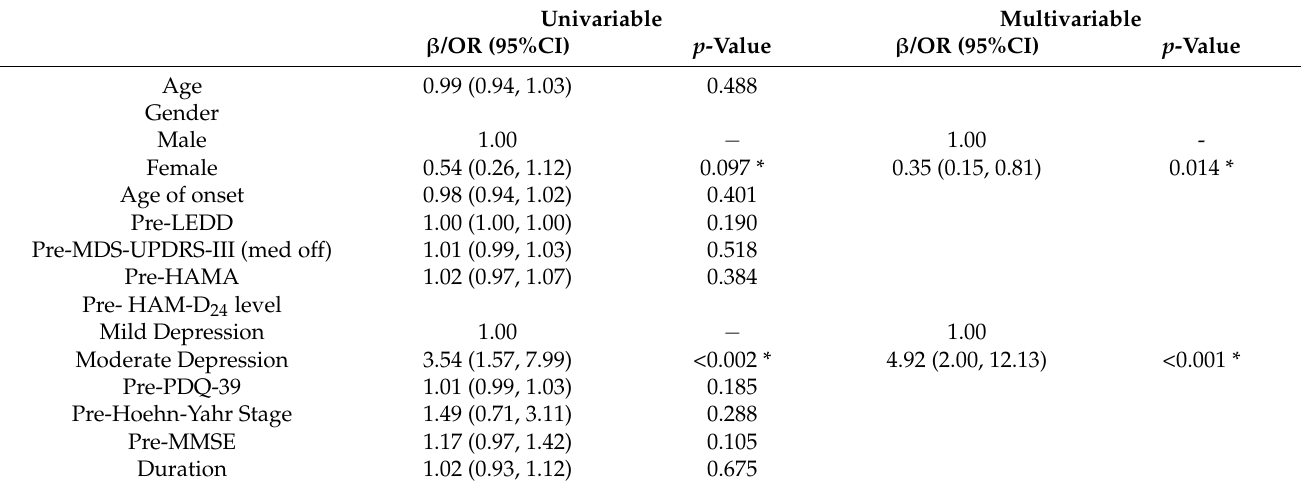
Table 5. Possible predictors of efficacy of STN-DBS on Parkinson’s disease depression. Univariable